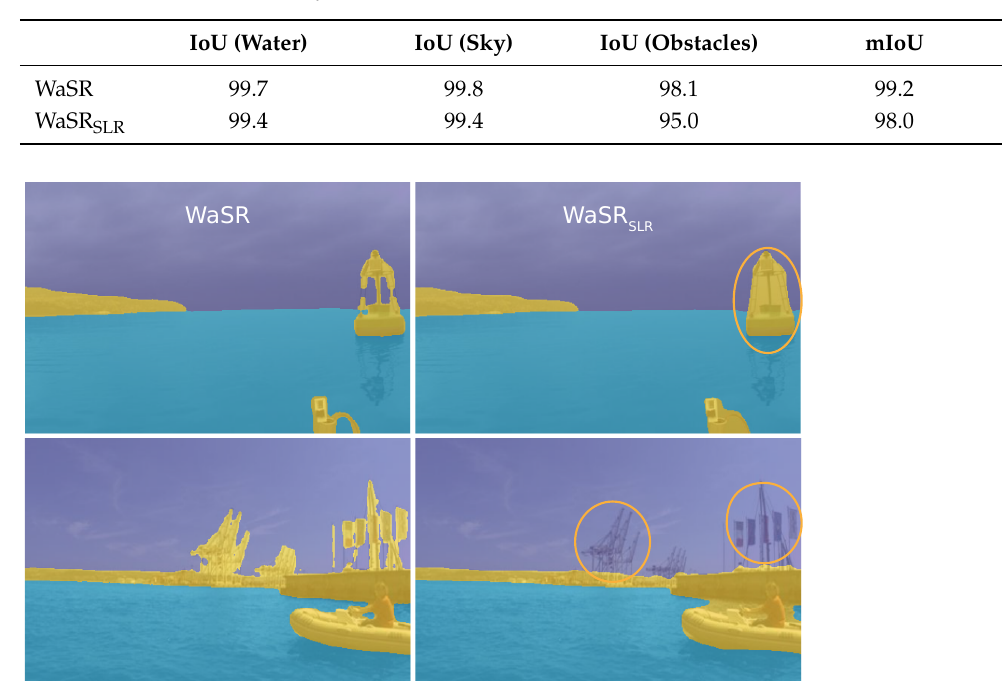
Table 2. Segmentation accuracy (IoU) of fully-supervised WaSR and WaSR SLR for the water, sky, and obstacles class, summarized by the mean over classes.